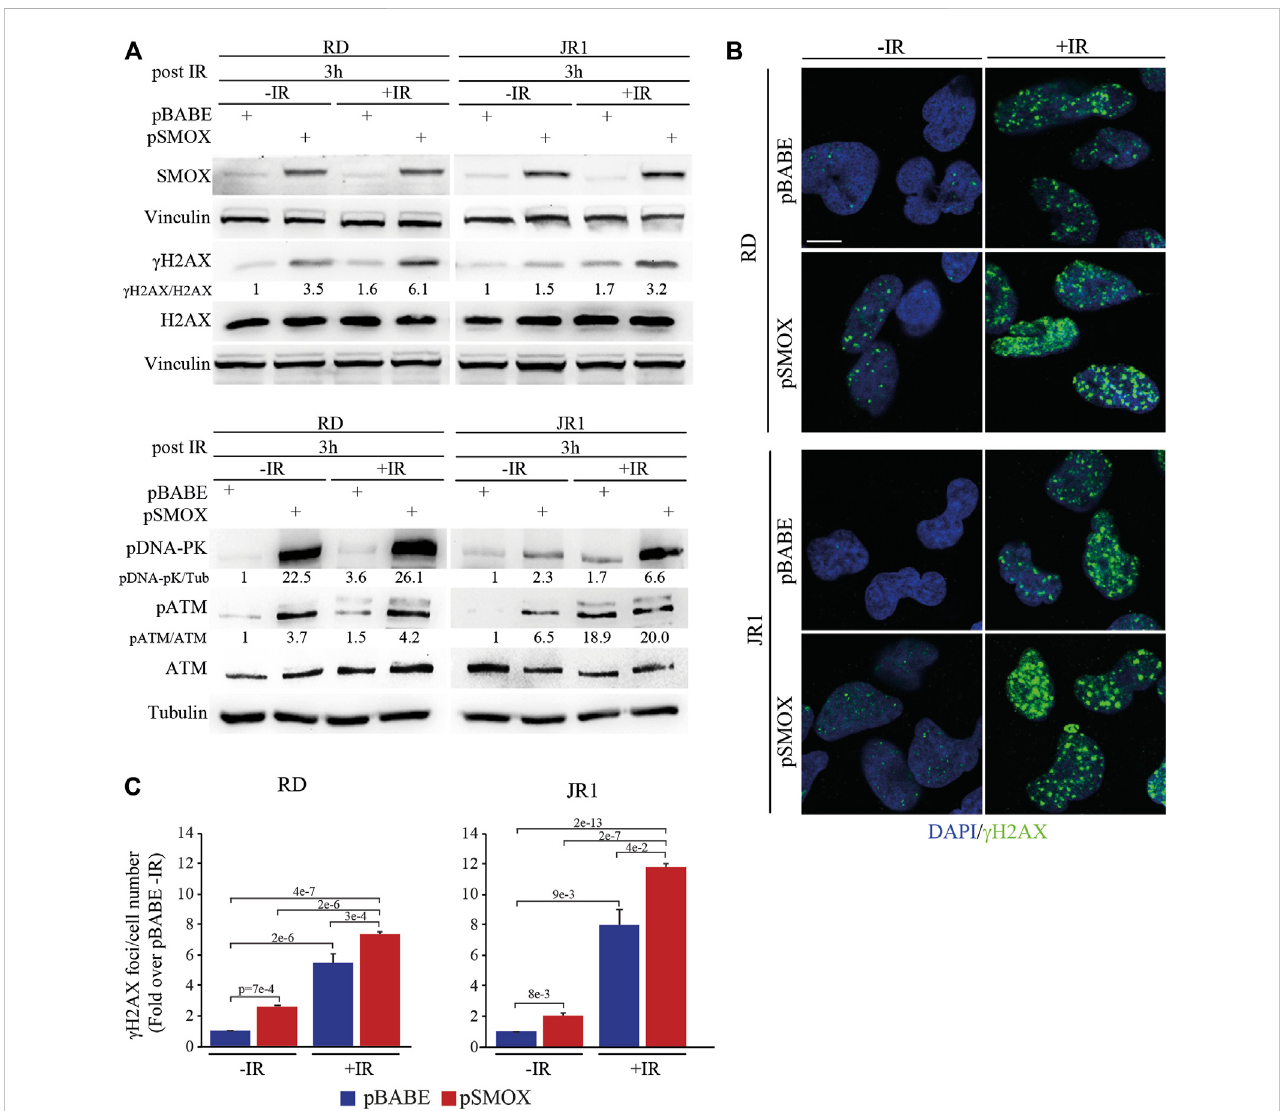
FIGURE 6 DNA damage induced by SMOX overexpression synergizes with irradiation in FN-RMS cell lines. (A) Representative western blot ( n = 2 independent biologicalreplicates)depictingtheeffectofirradiation(4Gy),SMOXoverexpressionandtheircombinationonDNAdamage.Thecellswereprocessed3 hpost irradiation.SMOX, γ H2AX,totalH2AX,pATM(Ser1981),totalATMandpDNA-PK(Thr2609)proteinlevelsweredetected.SMOXandpDNA-PKwerenormalized on Vinculin and Tubulin, respectively. γ H2AX and pATM were normalized on H2AXand ATM protein levels, respectively. Protein levels were expressedas fold increase over pBABE — IR values. (B) Representative immuno fl uorescence images of γ H2AX (green) ( n = 2 independent biological replicates) in RD and JR1cellstreatedasin (A) .DAPI(blue)wasusedasnuclearcounterstain.Imagesweretakenusingconfocalmicroscopywitha×60oilimmersionobjectivelens. Scale Bar = 10 μ m. (C) Histograms of γ H2AX fociper cell number inRD and JR1 cells treated as in (A) . Results wereexpressed as fold increaseover pBABE — IR values. Graph represents the mean of three independent experiments ±SD, one-way ANOVA. Exact p -values are reported in the fi